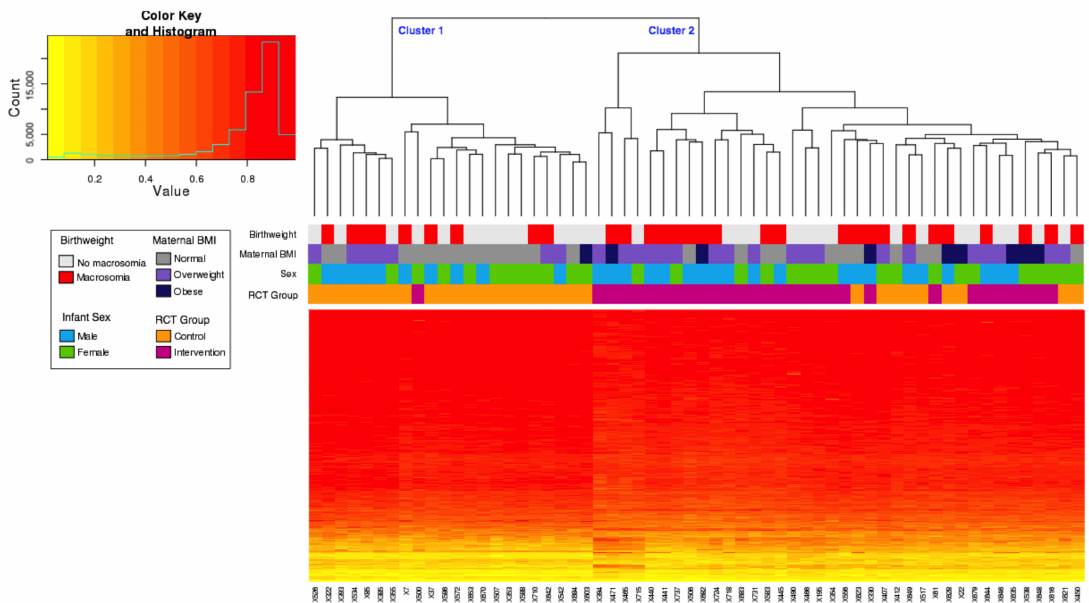
Figure 2. Hierarchical clustering and heatmap of HM850 methylation values of the top 1000 probes associated with intervention/control. Adjusted for infant sex, gestational age, chip, and chip position. The histogram depicts the distribution of methylation levels across all samples and probes, the beta value is plotted on the x-axis and number of probes on the y-axis. RCT: Randomised Controlled Trial. For all probes, the average beta value in the control samples was 0.602 and for the intervention samples was 0.598. In the top 1000 probes, detailed in the heat map, the average beta value for the control samples was 0.788 and for the intervention samples was 0.764. A total of 927 of the top 1000 ifferentially methylated probes showed decreased average methylation in the intervention group relative to control samples, with an average decrease of 3% in methylation per CpG site. Only 73 of the top 1000 probes had increased methylation in the intervention samples rather than the control samples, with an average increase of 6% in